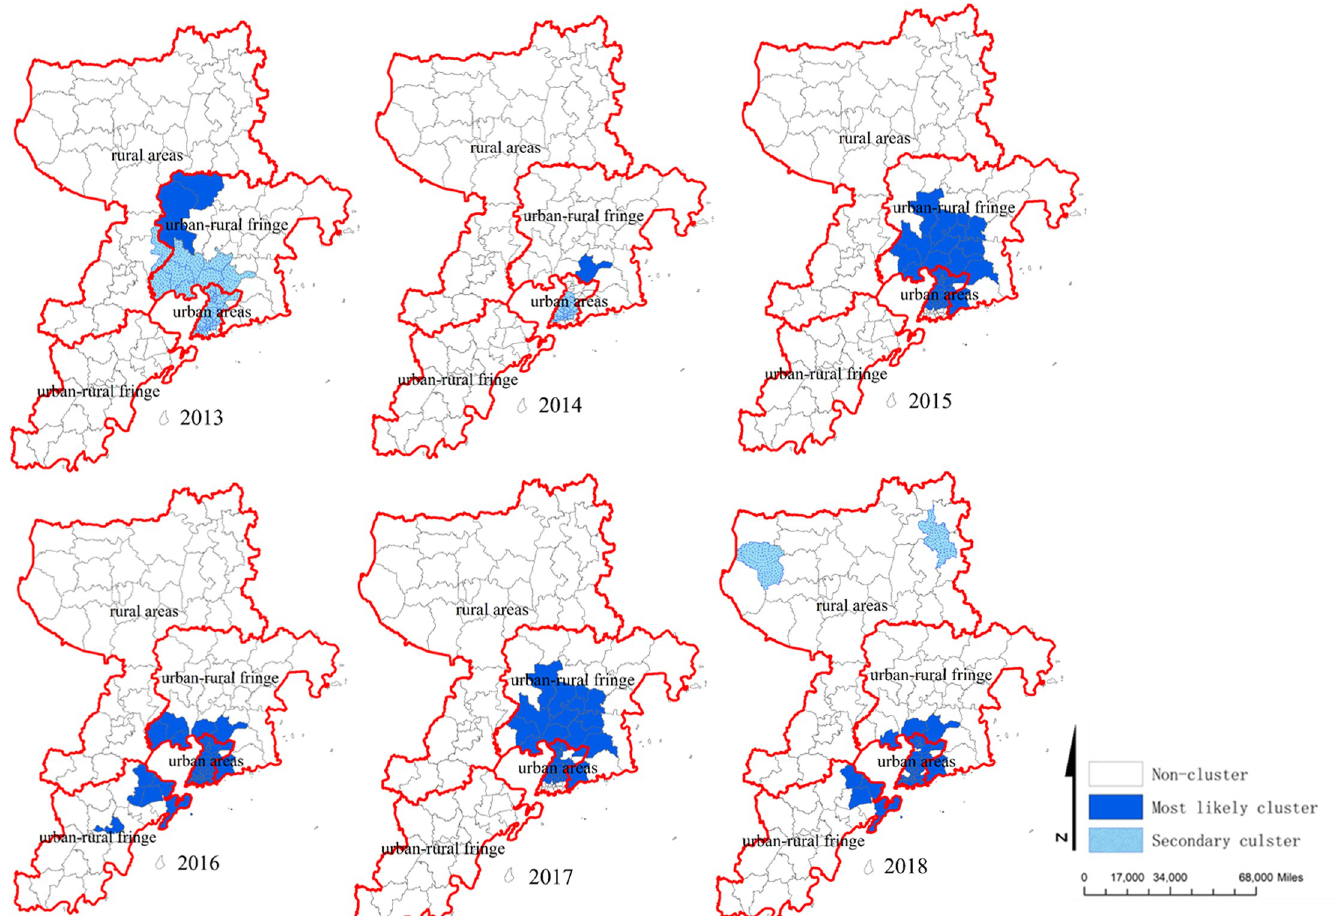
Fig 4. The spatial-temporal clusters of HFMD in Qingdao City,